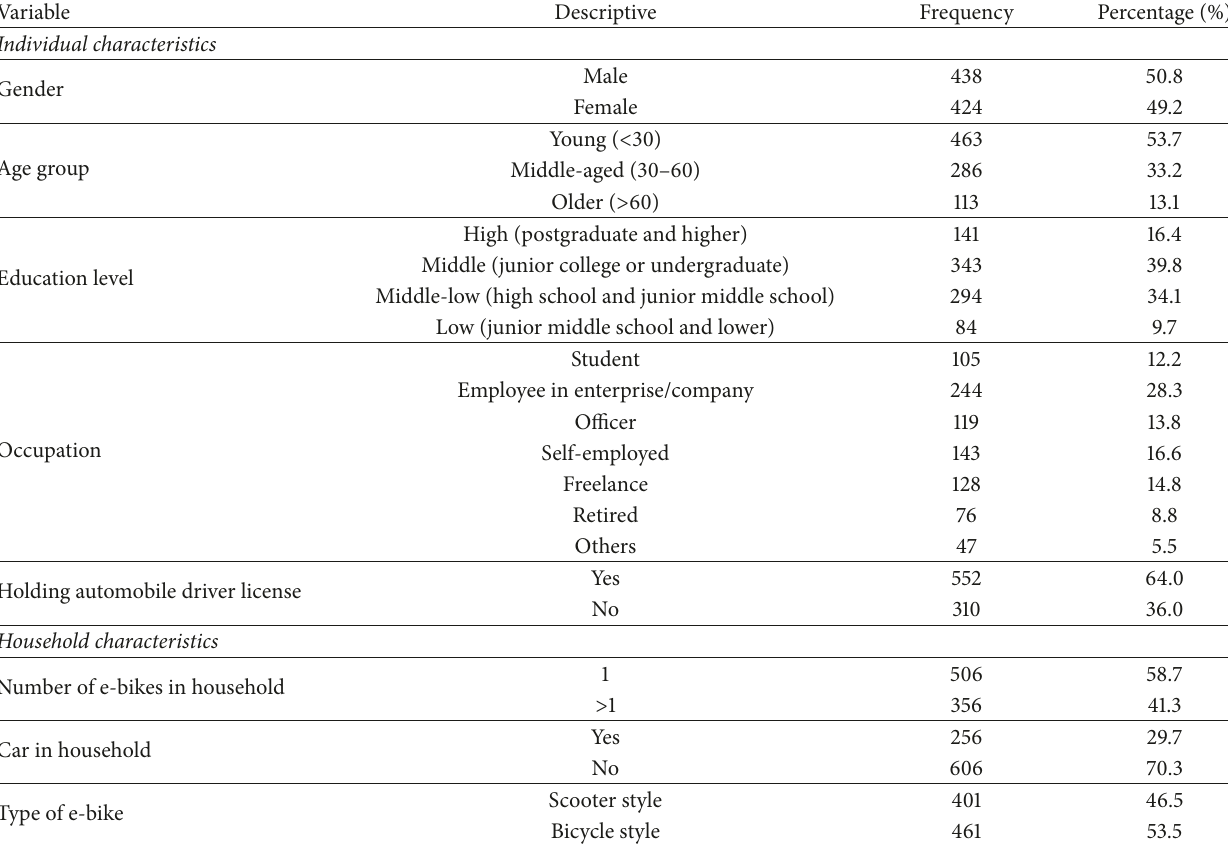
Table 2: Descriptive statistics for demographic